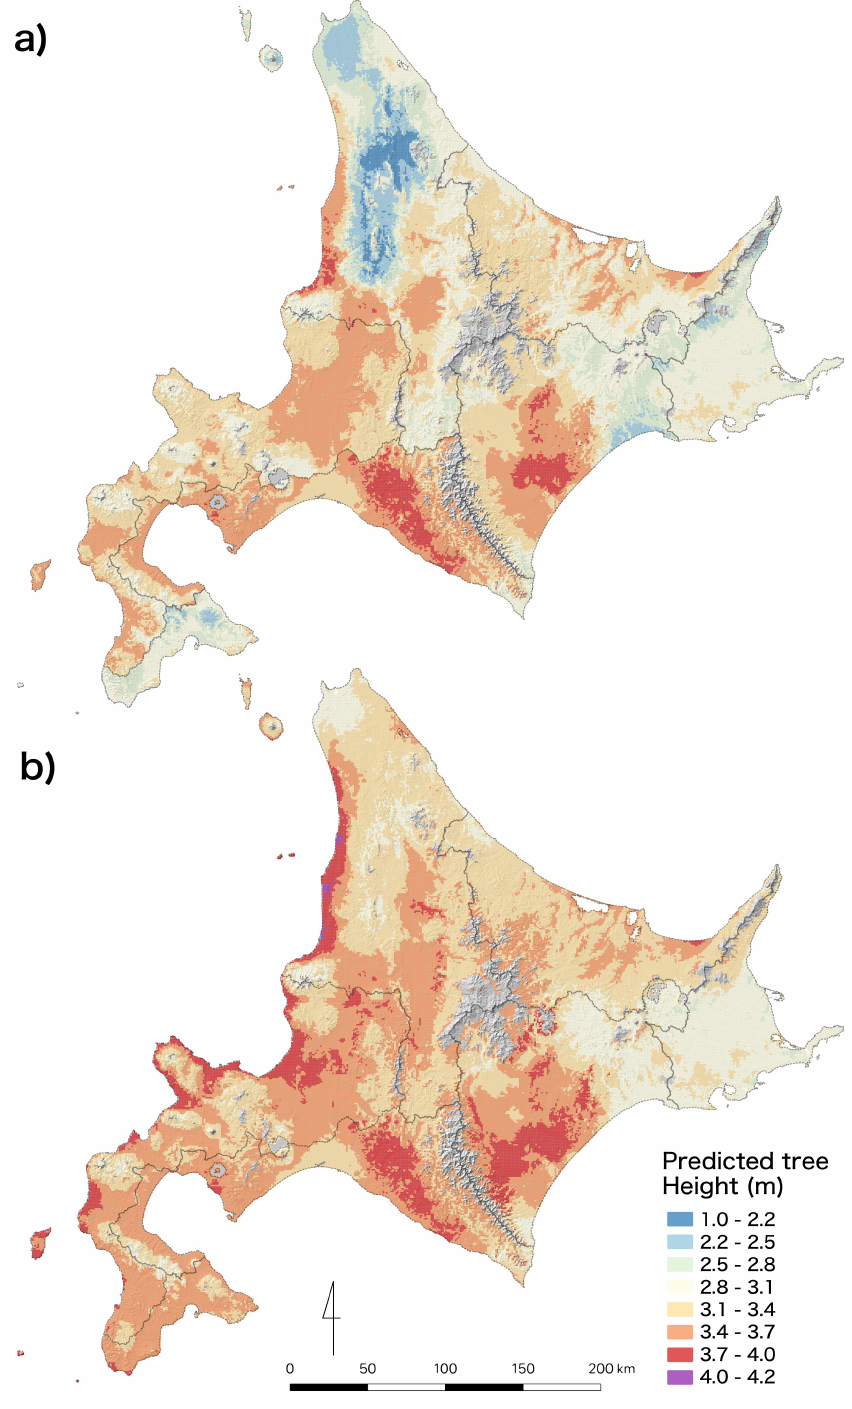
Figure 5. Predicted tree height for ( a ) local provenance and ( b ) optimum seed provenance. Gray area indicates alpine zone with less than 35 in the WI, which was excluded from the